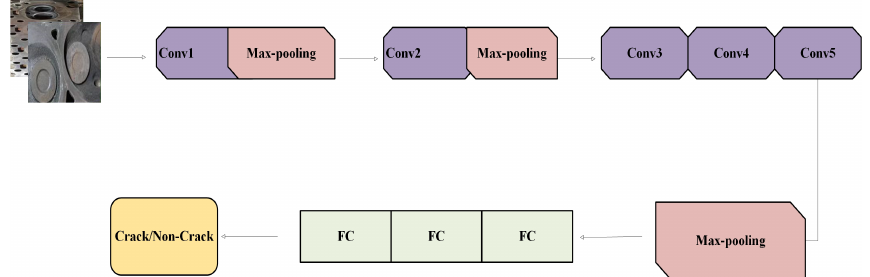
Figure 3. Framework of the AlexNet architecture.